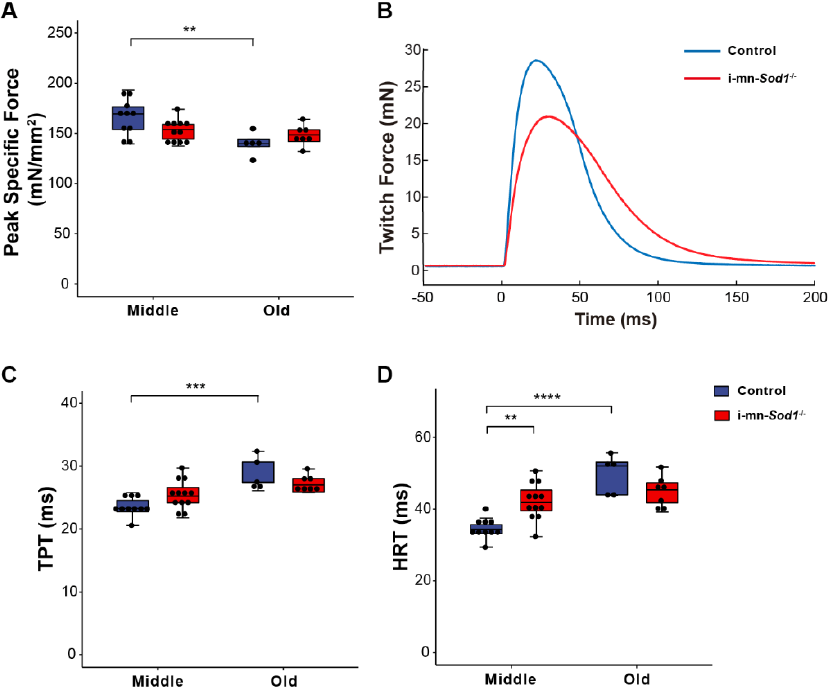
Figure 4. Comparison of lumbrical muscle contractile properties between control and i-mn- Sod1 -/- mice. Data are shown for ( A ) peak specific force for muscles of middle-aged and old control (blue) and i-mn- Sod1 -/- (red) mice. Additionally, shown are ( B ) representa- tive twitch contractions for muscles of control (blue) and i-mn- Sod1 -/- (red) mice at middle-age as well as data for ( C ) time to peak twitch tension (TPT), ( D ) half relaxation time (HRT) for muscles of middle- and old-aged control (blue; n = 10 for middle age, n = 5 for old age) and i-mn- Sod1 -/- (red; n = 12 for middle age, n = 7 for old age) mice. Data in A, C, and D are presented as individual data points (circle) with box plots and error bars indicating the minimum, first quartile, median, third quartile, and maximum number of the dataset. Data were analyzed by two-way ANOVA, ** p < 0.01, *** p < 0.001, **** p <